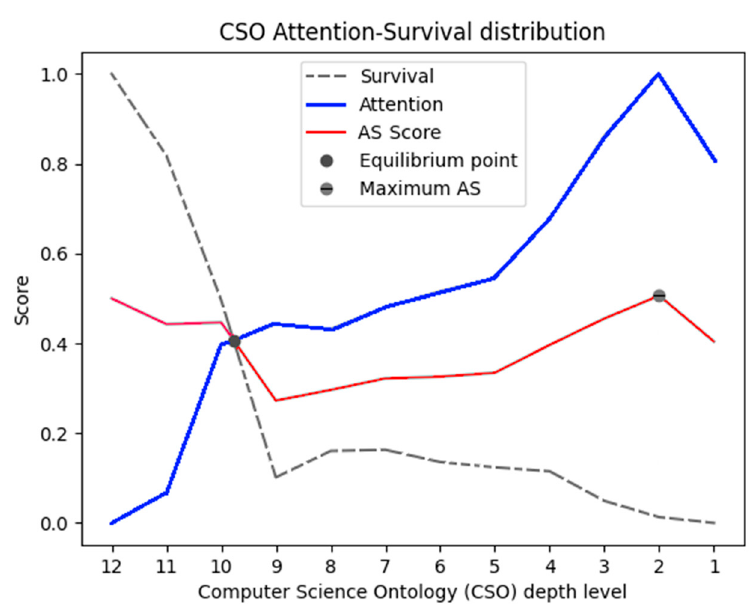
Figure 5. Evolution of the attention, survival, and attention–survival score (AS) throughout the CSO structure. α = 0.5.